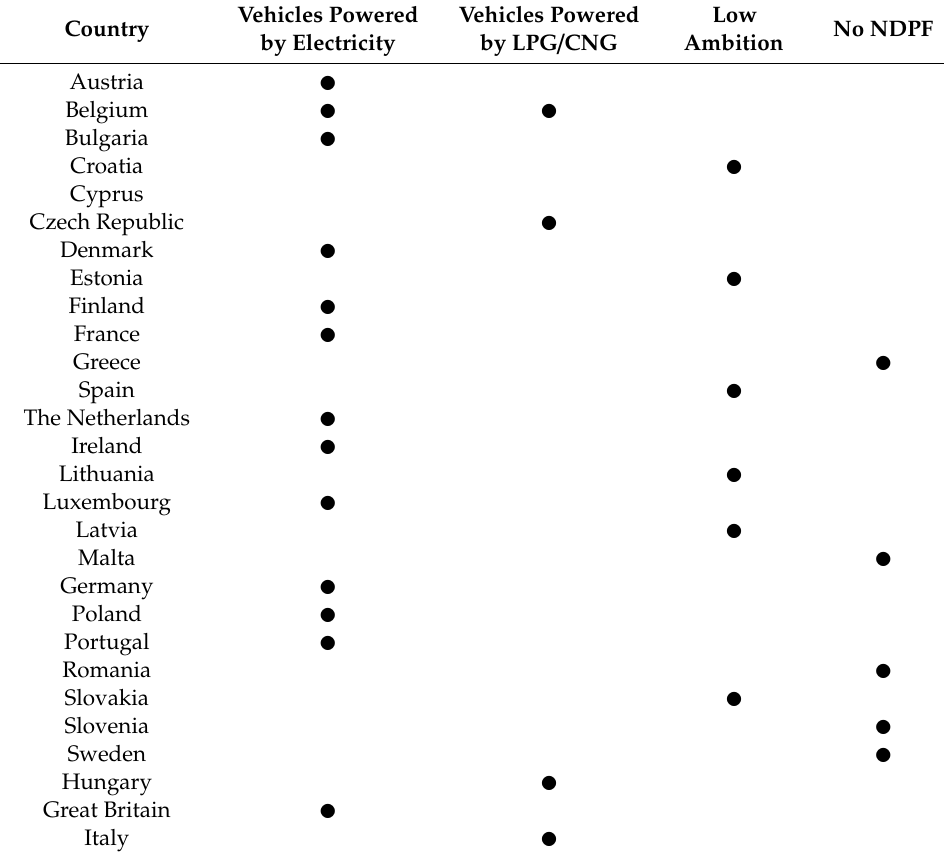
Low No NDPF Ambition